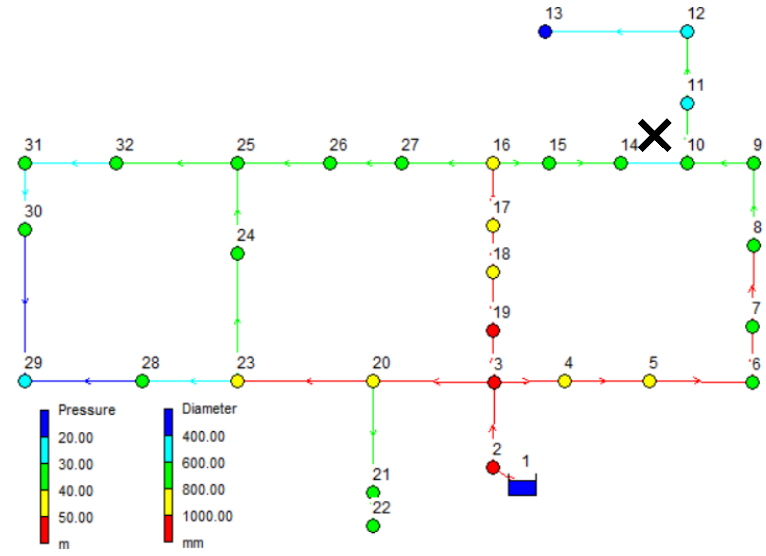
Figure 8. Hydraulic characteristics of solution 3 after the simulation of scenario 6.